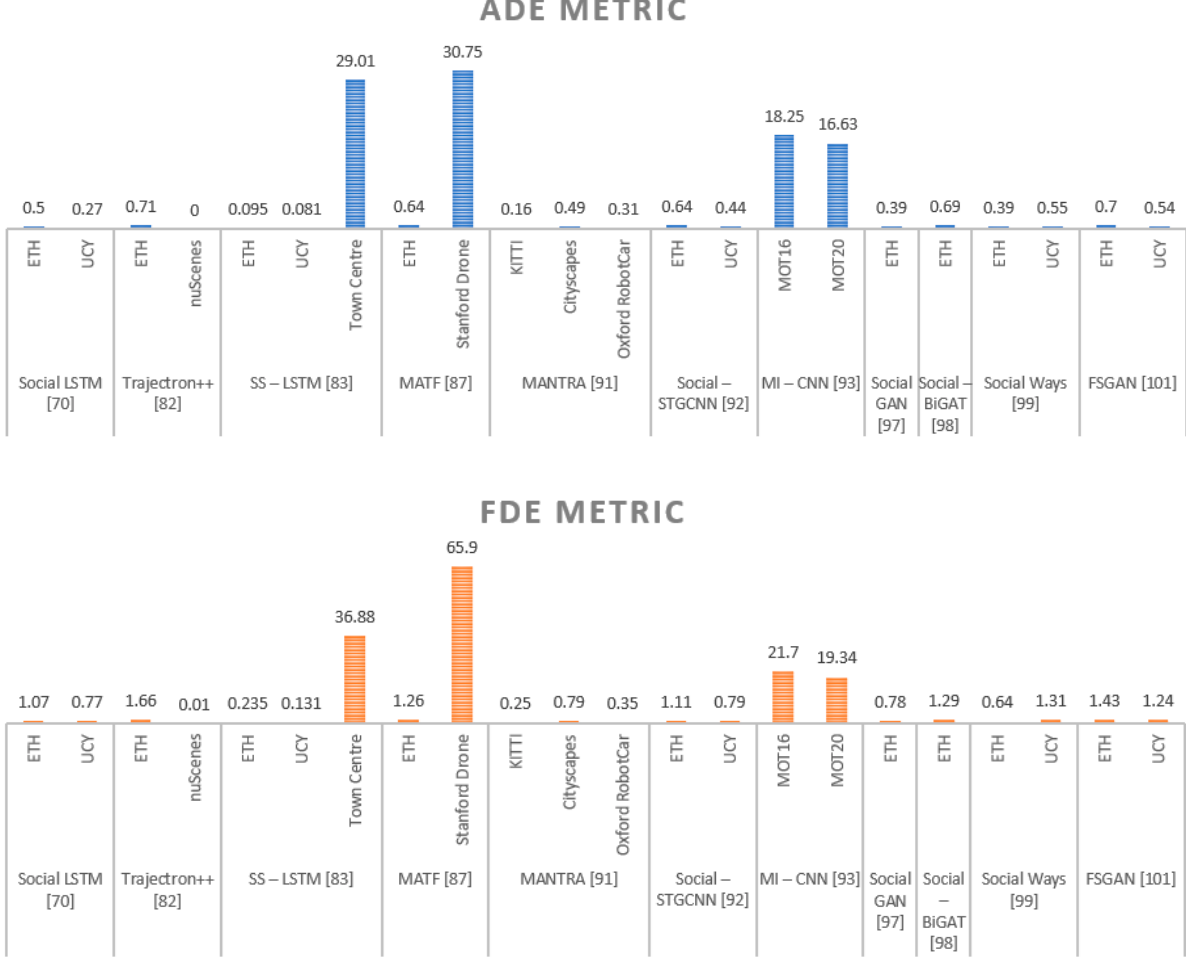
Figure 12. Comparative ADE and FDE metrics for each method referred in Table